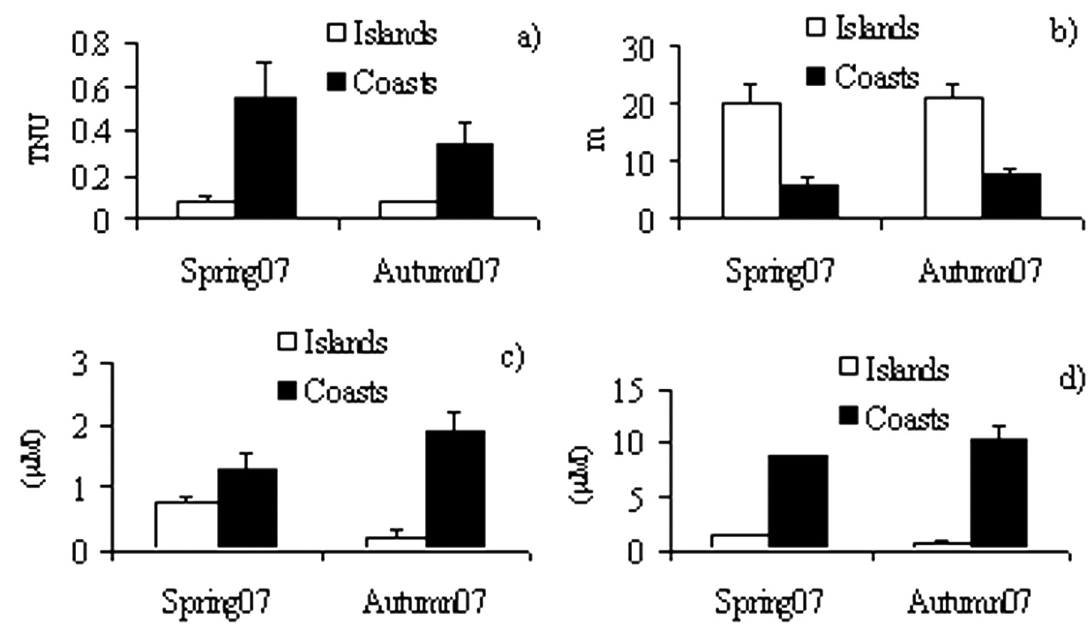
Fig . 1. – Values of turbidity (measured through a multiparametric probe) (a), transparency (measured through Secchi disc) (b), concentration of NH (c) and NO (d) obtained in two different surveys along the Tuscany coasts (mean±SE, 4 3